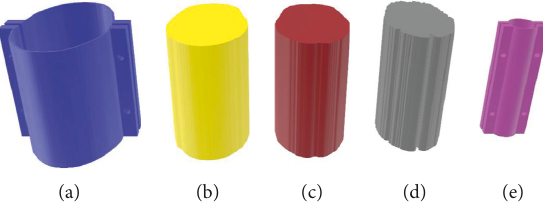
Figure 2: Computational design of the 2.5D human head tissue molds: scalp (a), skull (b), CSF (c), brain (d), and stroke (e) mold regions. Table 1: Phantom materials to be used in the fabrication of the solid tissue layers of the human head phantom. Material